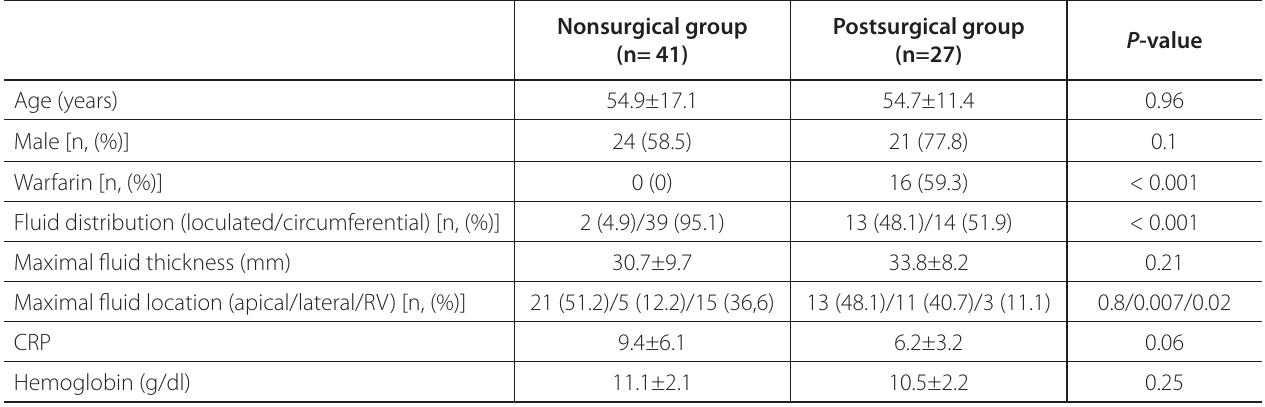
Table 1 . Baseline clinic, echocardiographic, and laboratory characteristics of